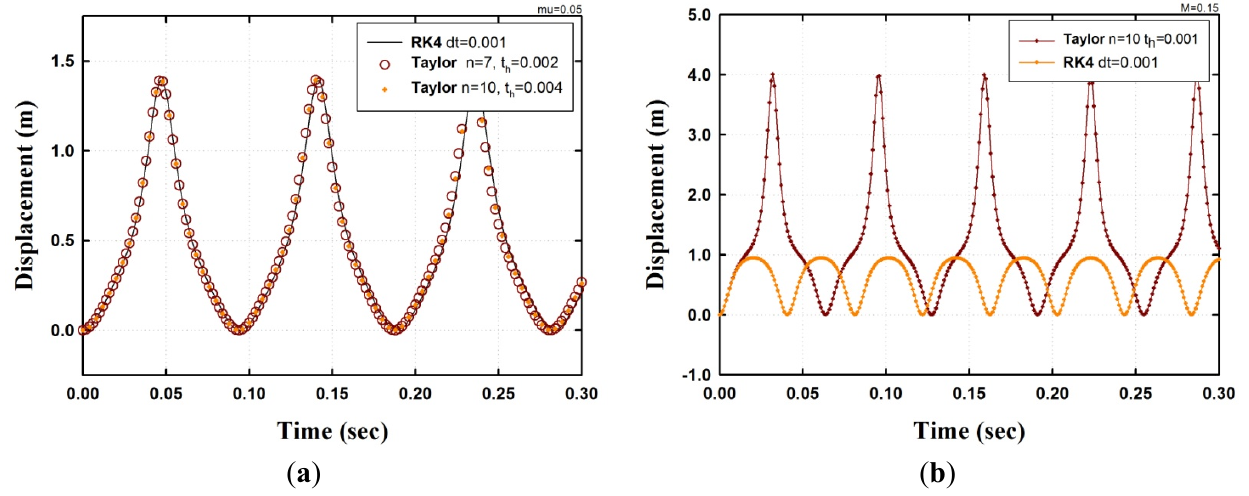
Figure 2. Comparing the result from SFN model using TSM with the result from RK4; ( a ) Displacement μ (cid:3404) 0.05, (cid:1832) (cid:3404) 200 kN ; ( b ) Displacement μ (cid:3404) 0.15, (cid:1832) (cid:2868)